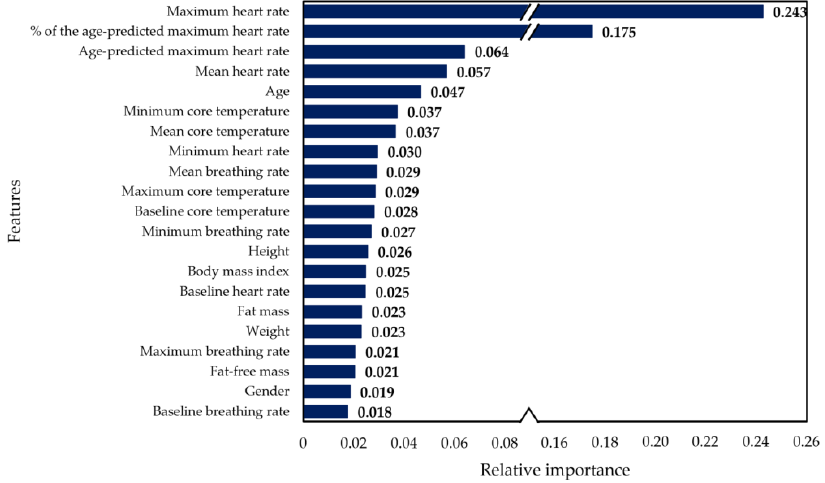
Figure 3. Relative importance of features for the XGBoosted Tree model.